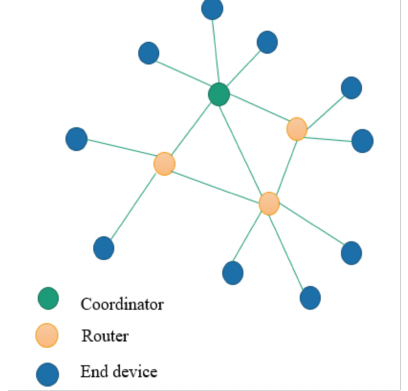
Figure 5. Zigbee